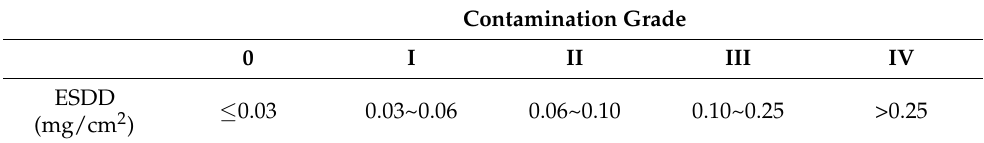
Figure 7. On-site photographing and contamination sampling of insulators: ( a ) on-site photographing; ( b ) contamination sampling. Table 1. Standard for theinsulator contamination